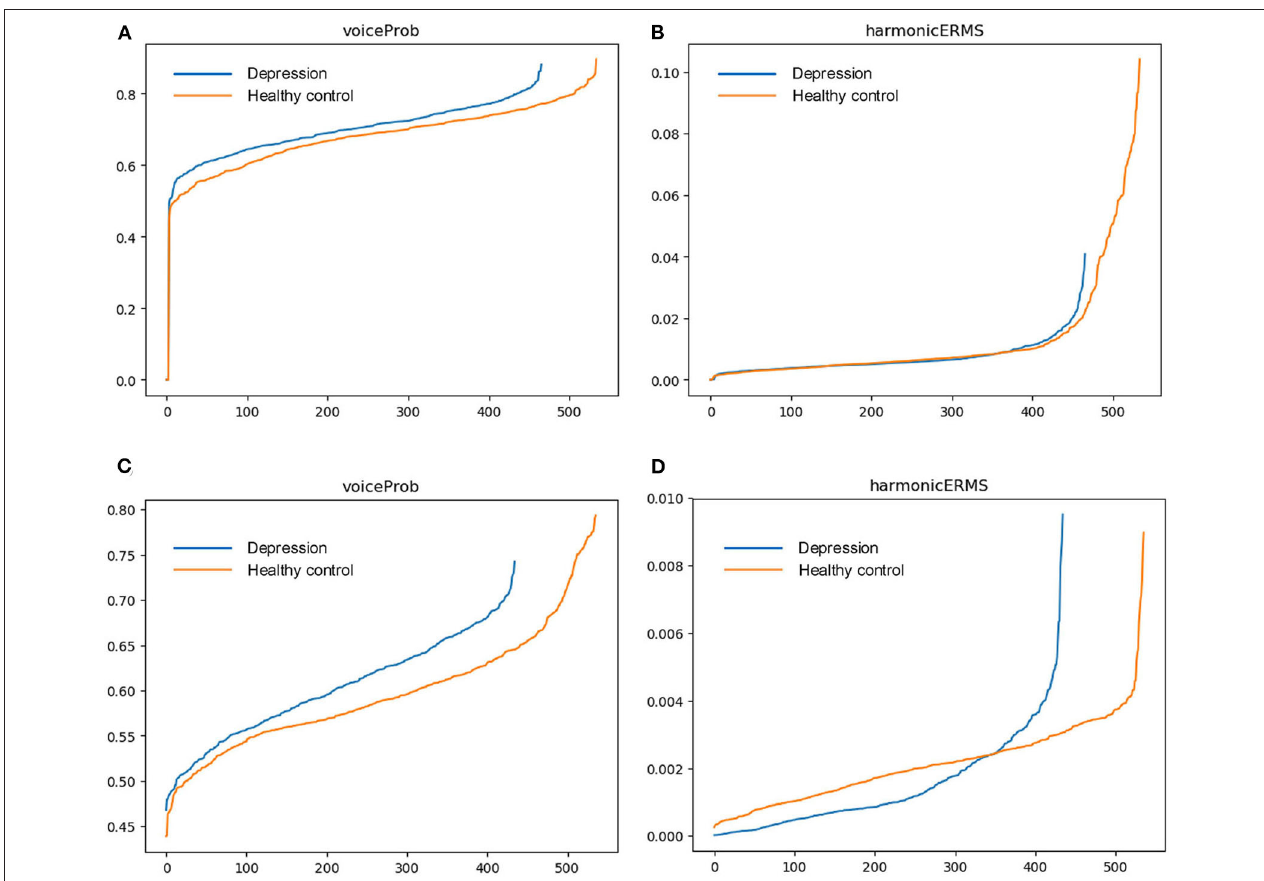
FIGURE 1 | Feature (voiceProb and harmonticERMS) comparison. (A,B) are features mean values on the Distress Analysis Interview Corpus - Wizard of Oz (DAIC-WOZ) corpus, while (C,D) are features mean values on the MODMA corpus.